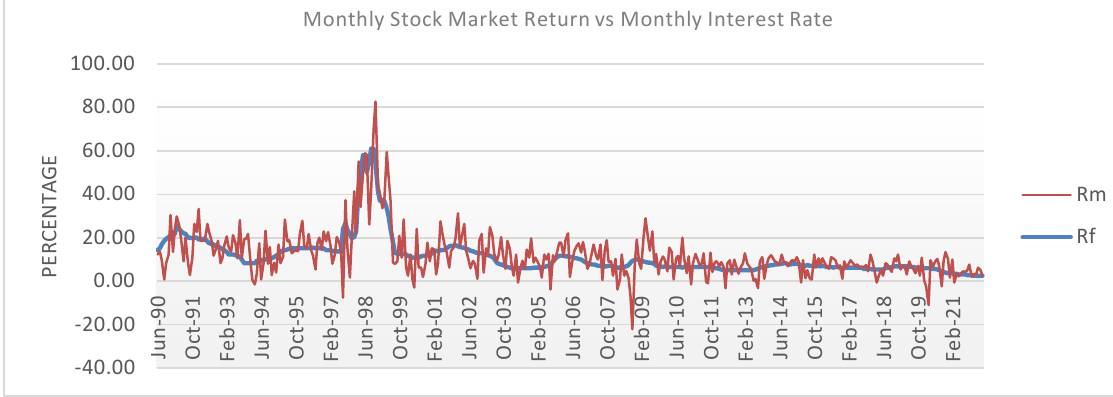
Figure 4: Comparison of Stock Market Return and Monthly Risk-Free Investment Return